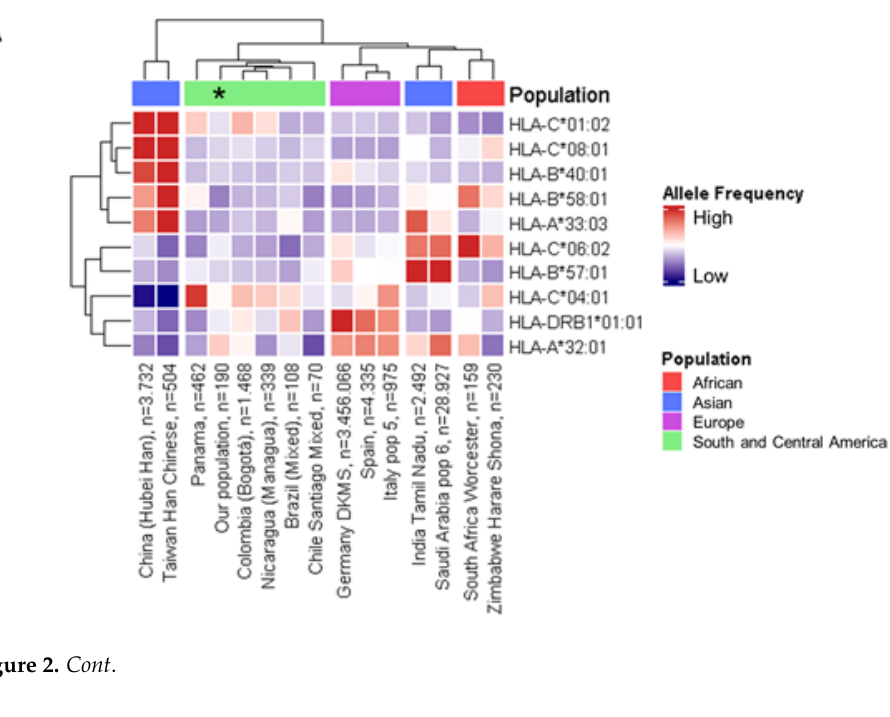
Figure 2. Comparison of HLA allele frequencies in different world populations, including the Chilean population from Talca. ( A ) Hierarchical population clustering; ( B ) Principal component analysis. * The studied population. 3. Discussion Genomic variability among populations can offer new opportunities to detect genetic variants associated with drug response and disease susceptibility. Unfortunately, LA populations have been largely underrepresented in these studies. In this context, the present work provides a genome ‐ wide Chilean dataset from Talca using the Illumina Global Screening Array, allowing to increase our knowledge of the genetic patterns in a rural LA population. The admixture patterns of the Chileans is determined by the interaction of ancient populations and more recent demographic movements [11]. The first Spaniards arrived